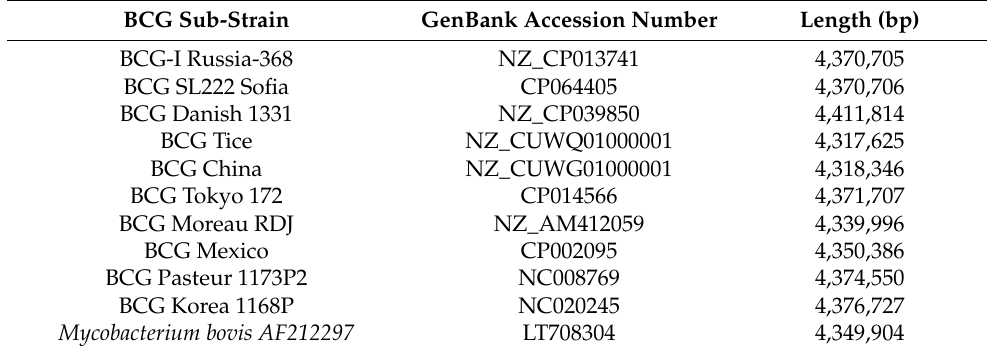
Table 1. Name, GenBank reference number and size of used BCG sub-strains with complete genome sequence for phylogenetic